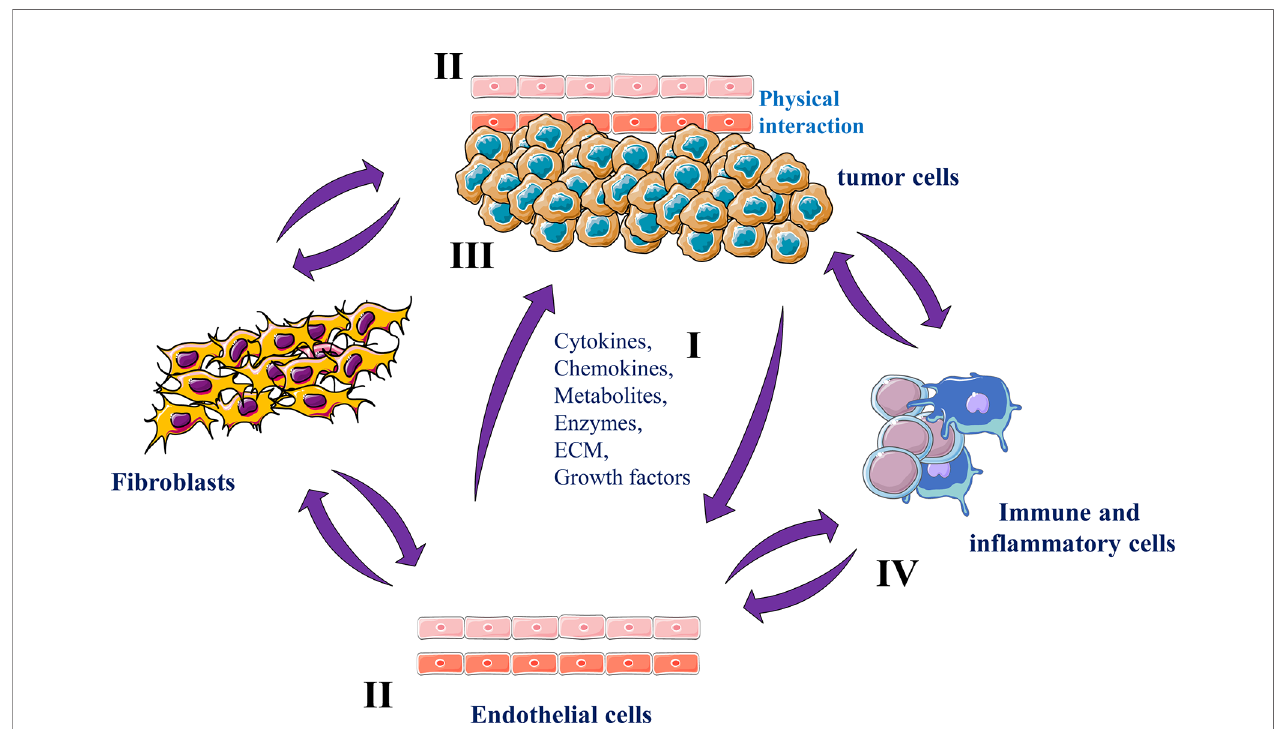
FIGURE 4 | Endothelial cells and cancer cells interactions Tumor endothelial cells and tumor cells secrete various molecules and ECM components in the tumor microenvironment (I) that mediate tumor angiogenesis (II) and growth (III). Tumor endothelial cells can also reciprocally interact with various stromal cells that in turn participate in tumor progression and angiogenesis and